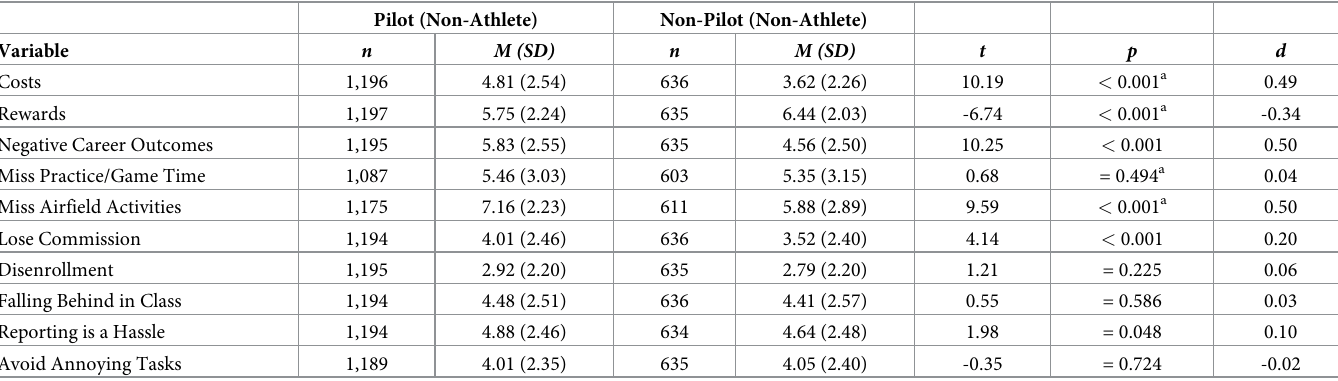
Table 5. Perceived costs and reward as a function of future pilot